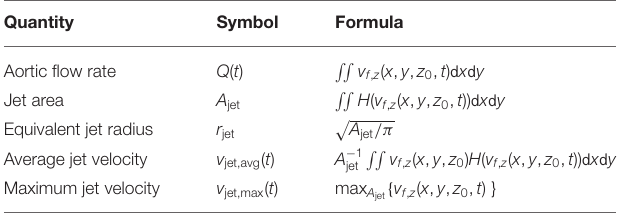
TABLE 1 | Definition of physical quantities for flow